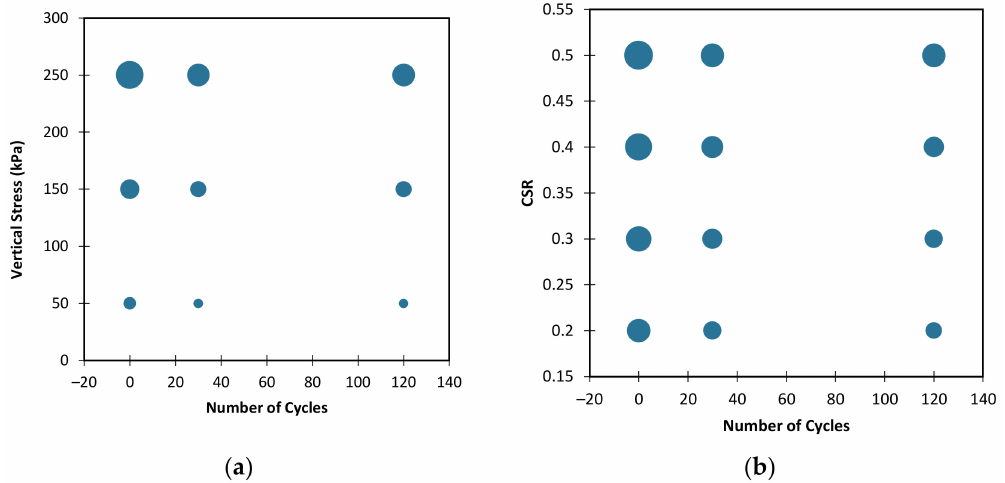
Figure 15. Effects of number of loading cycles, along with ( a ) vertical stress and ( b ) CSR, on the damping